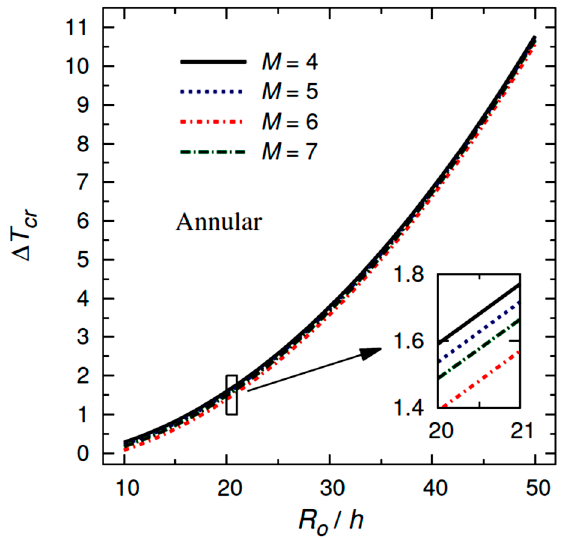
Figure 2. Convergence of the critical buckling temperature ∆ T cr of simply supported SGP annular plates ( R i / R o = 0.3, κ = 1, E ζ = 0.05 V/m, w g = 0.1%, µ = γ = 2 nm, ∆ C = 0.5%, e 0 = 3 × 10 5 , 𝐽 (cid:2869) = 100 , 𝐽 (cid:2870) = 10 ).